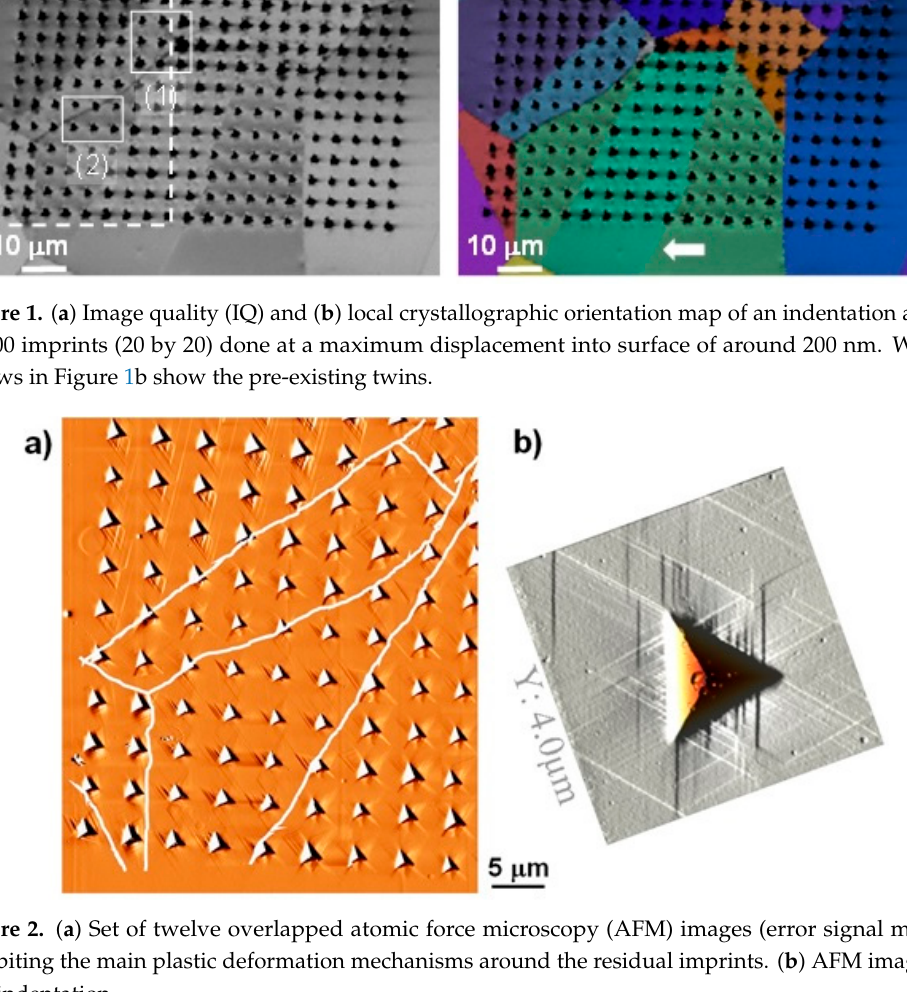
Figure 1. ( a ) Image quality (IQ) and ( b ) local crystallographic orientation map of an indentation array of 400 imprints (20 by 20) done at a maximum displacement into surface of around 200 nm. White arrows in Figure 1b show the pre-existing twins.